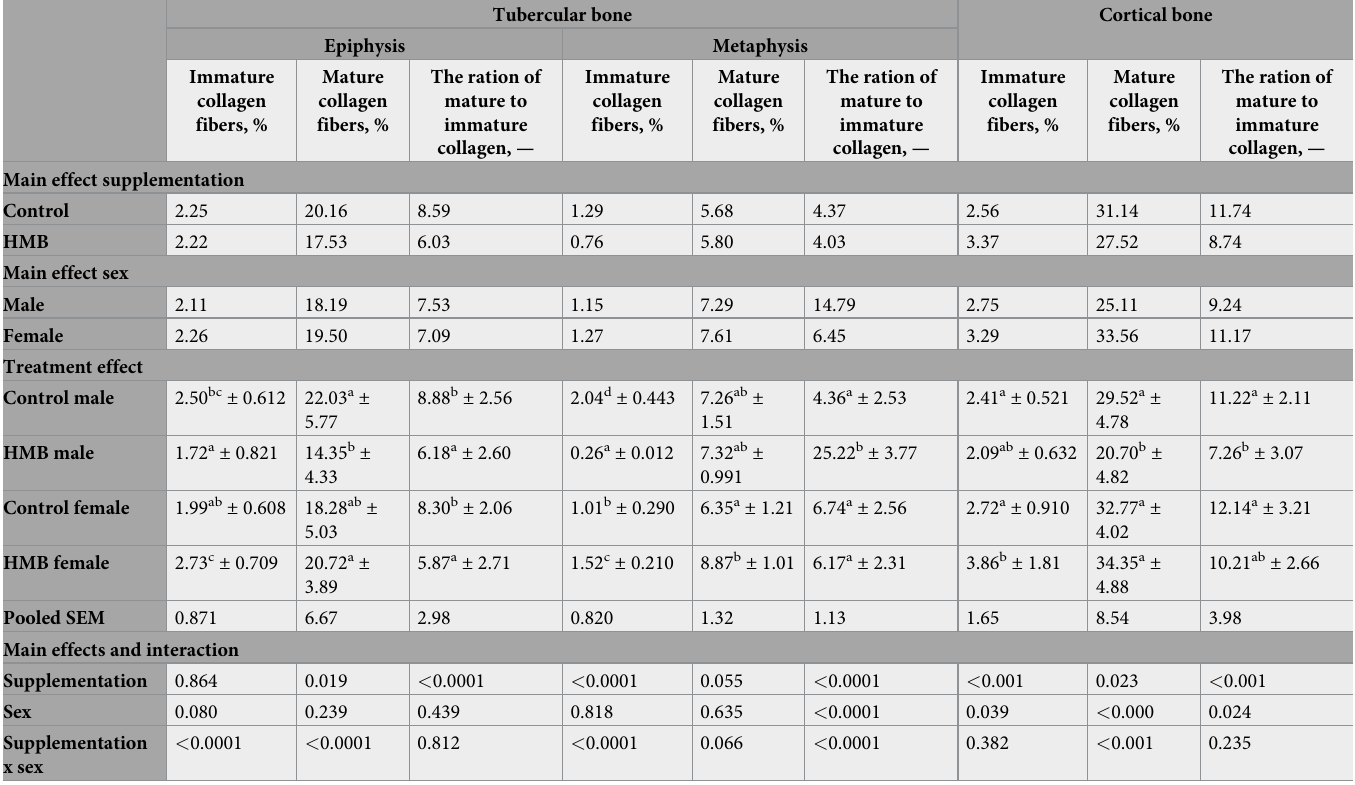
Table 4. The effect of maternal treatment with HMB on humerus collagen structure cortical and tubercular bone in newborn piglets. Tubercular bone Cortical bone